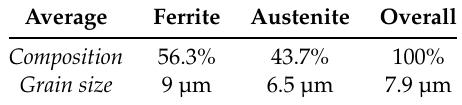
Table 2. Microstructure statistics summarized. The data was collected from EBSD scans.